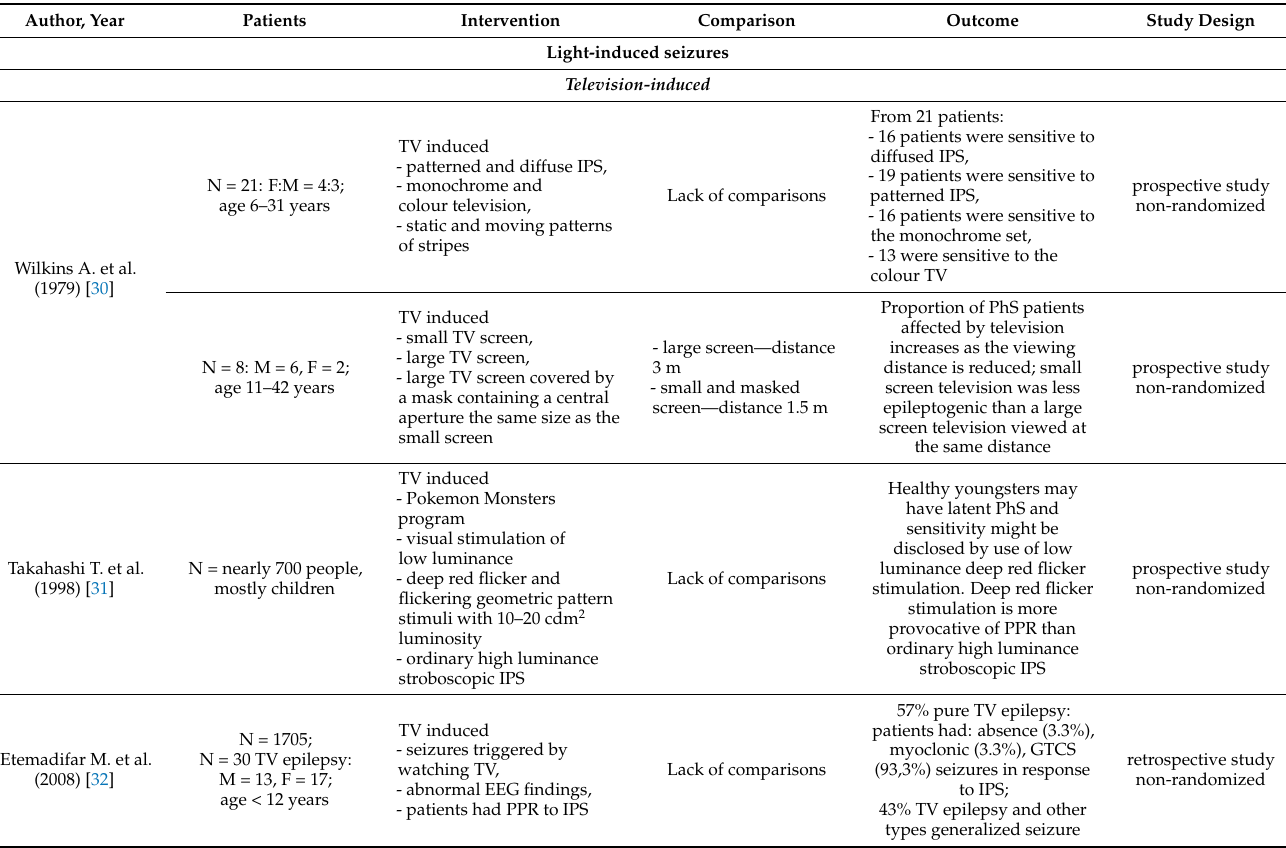
Table 1. Qualitative synthesis